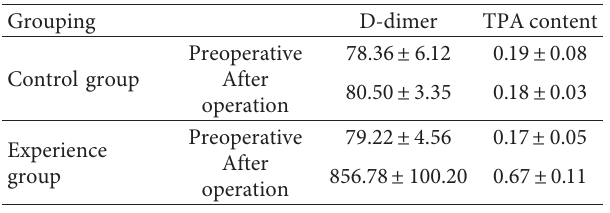
Figure 3: Results of cardiac valve morphology measurement in each Table 2: D-dimer before and 4 weeks after targeted tPA gene transfer and tPA content ( μ g/L, X ± s ).